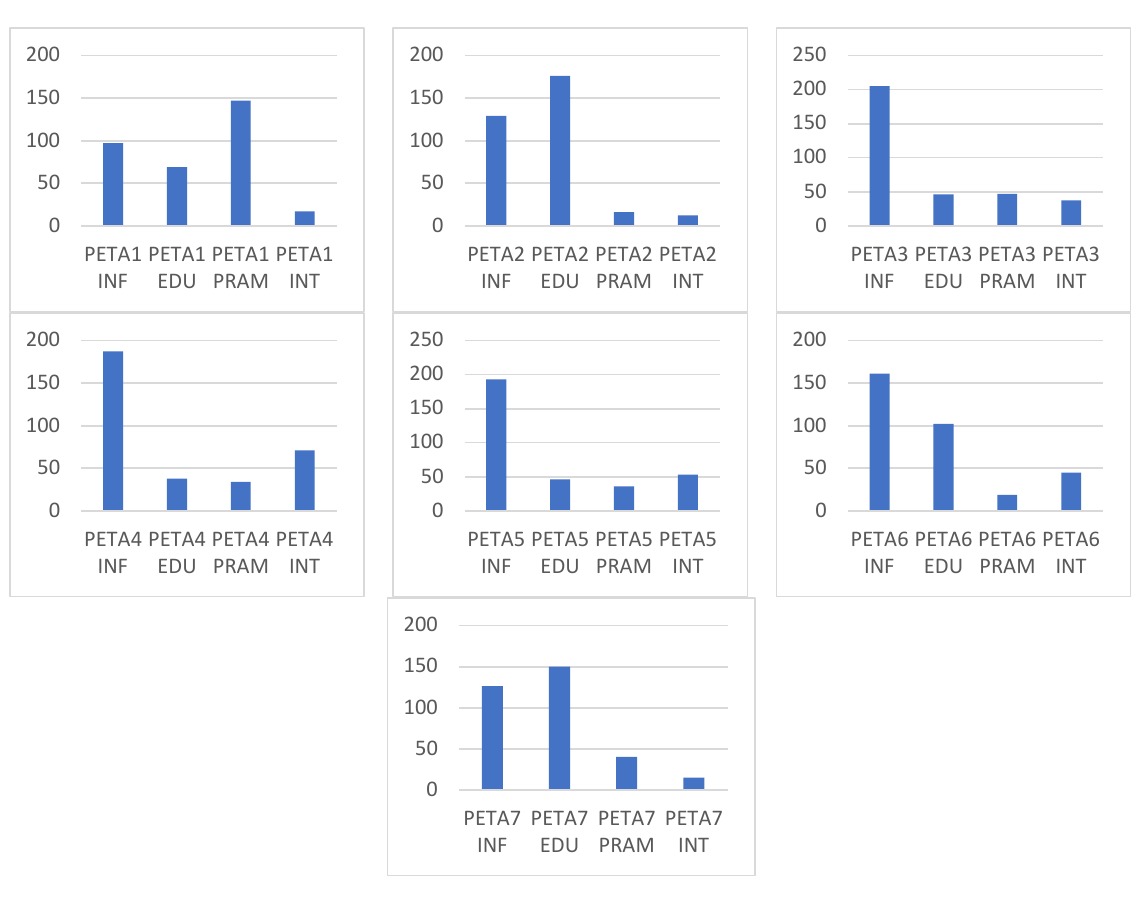
Figure 2. Distribution of preferred by respondents’ content in buying model stages.